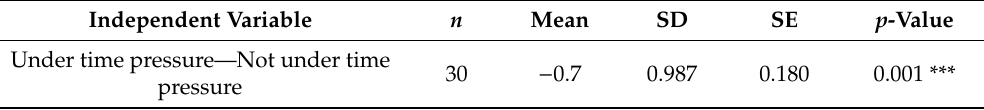
Table 10. Paired t -test results for the number of products purchased.